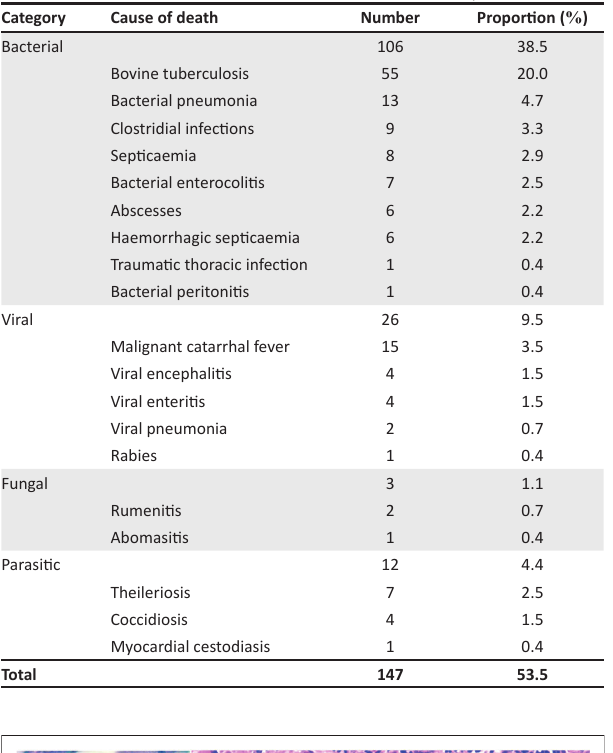
TABLE 2: Cause of death in 275 African buffaloes: Infectious and parasitic diseases. Category Cause of death